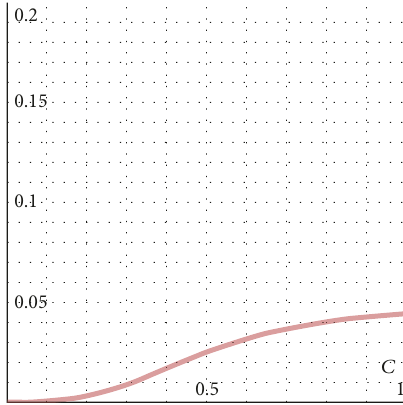
Figure 4: A typical profile of 𝑓 2 (𝑐) with 𝐾 𝑄 = 0.05 , 𝑚 1 = 3 , and 𝑐 𝑐𝑟𝑖𝑡1 = 0.5 .